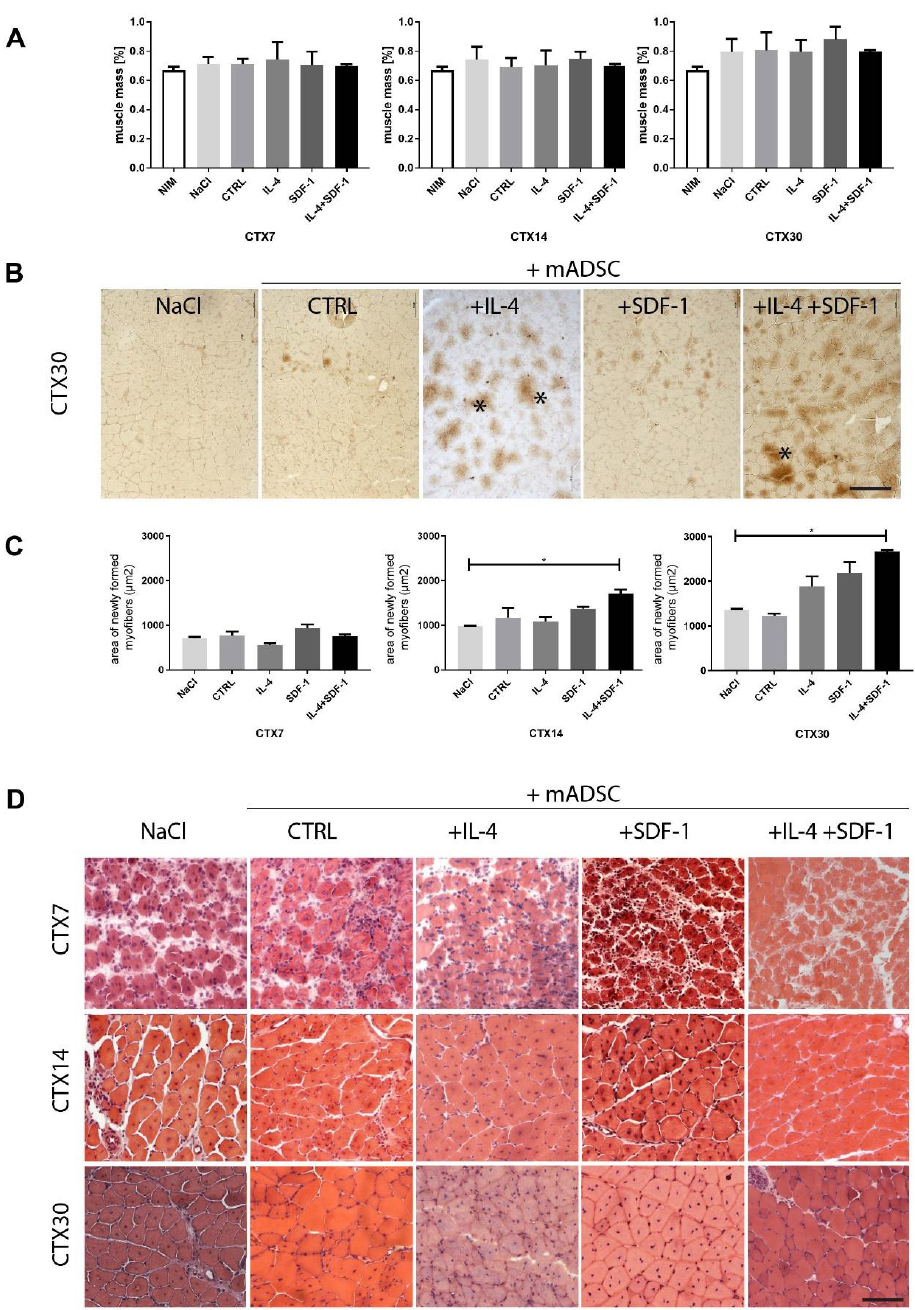
Figure 3. Regeneration of mouse skeletal muscles which received mADSCs - control or pretreated either with IL-4, SDF-1, or IL-4 and SDF-1. ( A ) Weight of intact, injured control and ADSC transplanted skeletal muscles related to the weight of the mouse, analyzed at day 7, 14, and 30 of regeneration. ( B ) Localization of mADSCs within the skeletal muscle at day 30 of regeneration using immunodetection of GFP (brown). Stars indicate skeletal myofibers generated with the participation of mADSCs, bar = 100 µ m. ( C ) Area of newly formed myofibers within the regenerating muscle analyzed at day 7, 14, and 30 of regeneration depending on the injected solution. ( D ) Histological analysis of regenerating muscle injected with NaCl or with mADSCs and analyzed at day 7, 14, and 30 of regeneration, hematoxylin & eosin staining. CTX7 - day 7; CTX14 - day 14; CTX30 - day 30 of regeneration, Bar = 100 µ m. For each experimental group n ≥ 3. Data have been analyzed using Kruskal-Wallis test. * p <